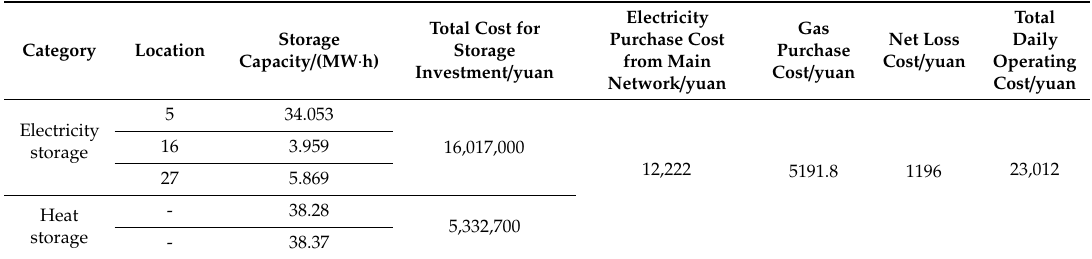
Table 3. Planning Table 3. Planning Results. Table 3. Planning Results.